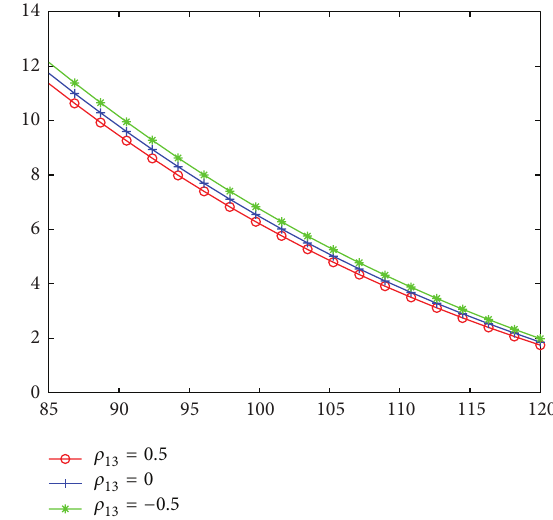
Figure 5: The influence of covariance 𝜌 13